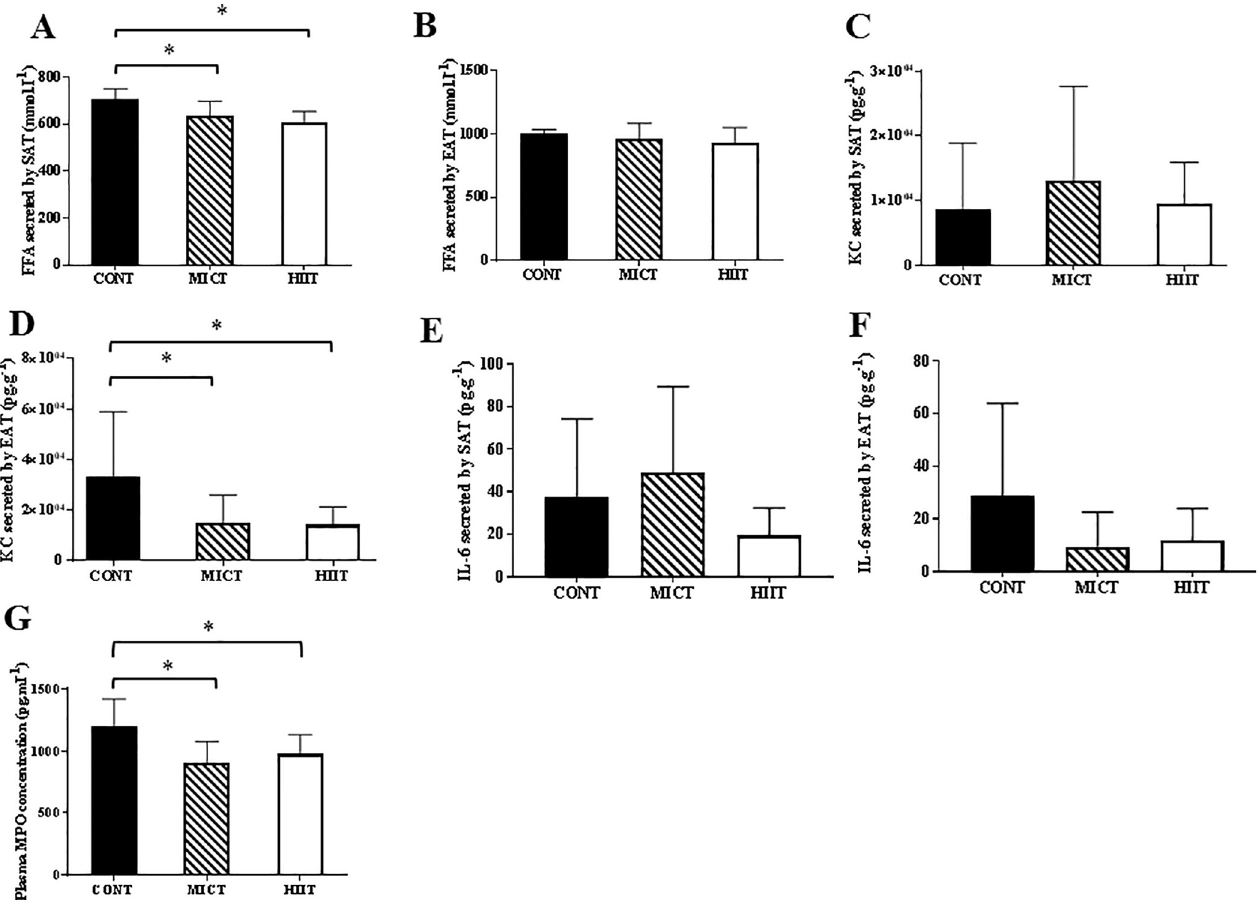
Fig 5. Effect of 10 weeks of exercise training on adipose tissue and systemic inflammation. Free fatty acid (FFA) secretion by subcutaneous adipose tissue (A) and visceral adipose tissue (B). Keratinocyte-derived chemokine (KC) secretion by subcutaneous adipose tissue (C) and visceral adipose tissue (D). IL-6 secretion by subcutaneous adipose tissue (E) and visceral adipose tissue (F). Plasma myeloperoxidase (MPO) concentration (G). Data are expressed as the mean ± SD. � p � 0.05 vs CONT.